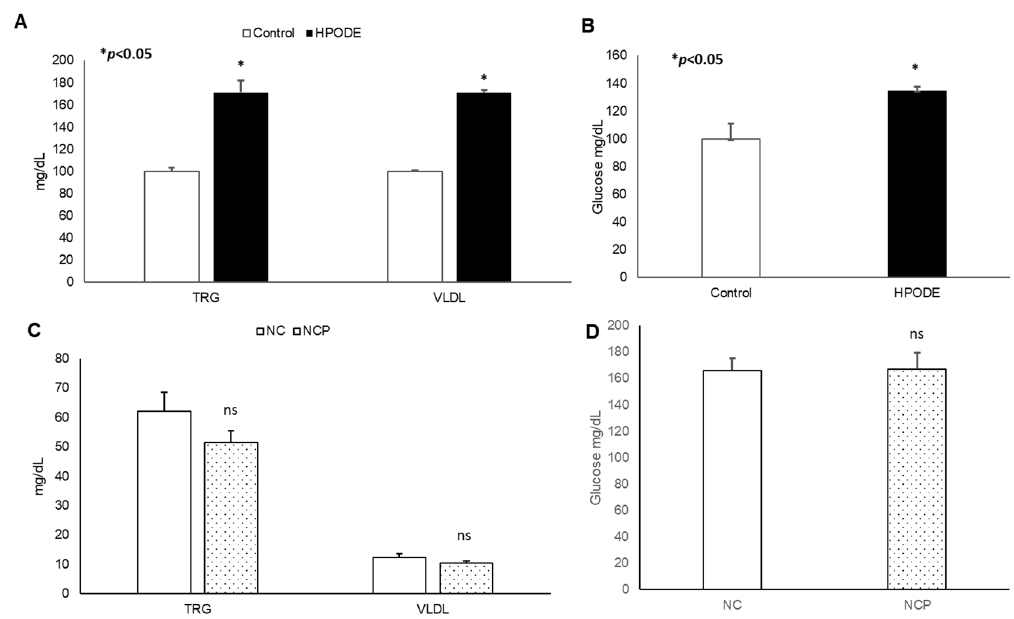
Figure 3. Plasma lipid and glucose levels of mice. Plasma lipid and glucose levels in 13-HPODE diet-fed animals in ( A , B ) acute and ( C , D ) chronic conditions Values are represented as mean ± SEM. Significance was considered as * p < 0.05, ns: not-significant. NC, Normal chow; NCP, Normal chow supplemented peroxidized fat; TRG, Triglycerides; VLDL, Very low-density lipoprotein.